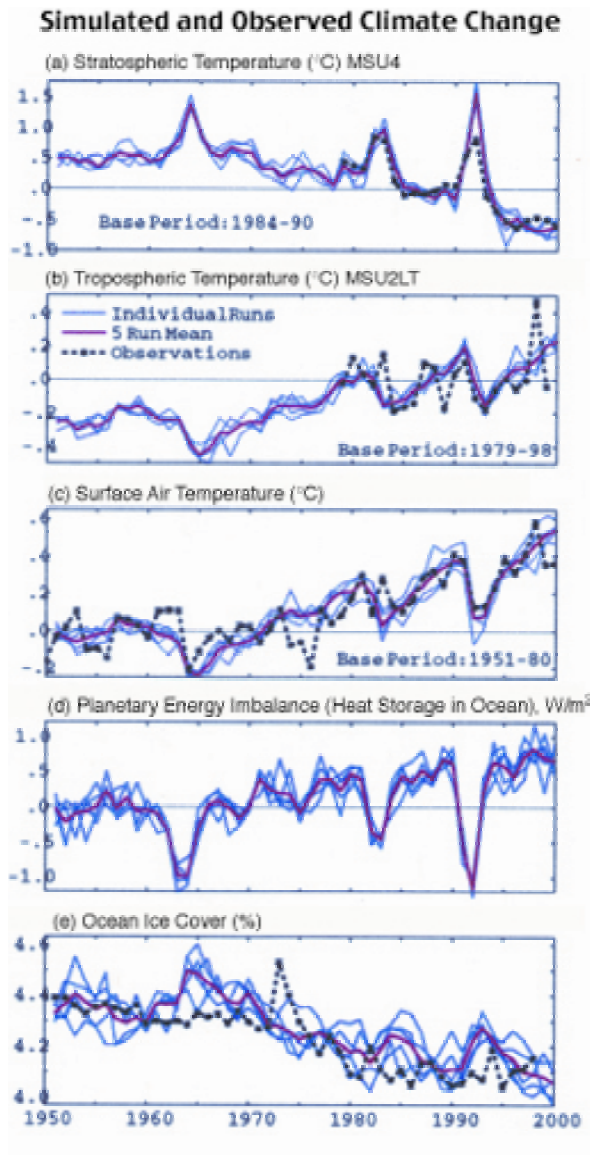
FIGURE 20. Simulated and observed climate change for 1950–2000. Note in (b) failure of model to reproduce observations after